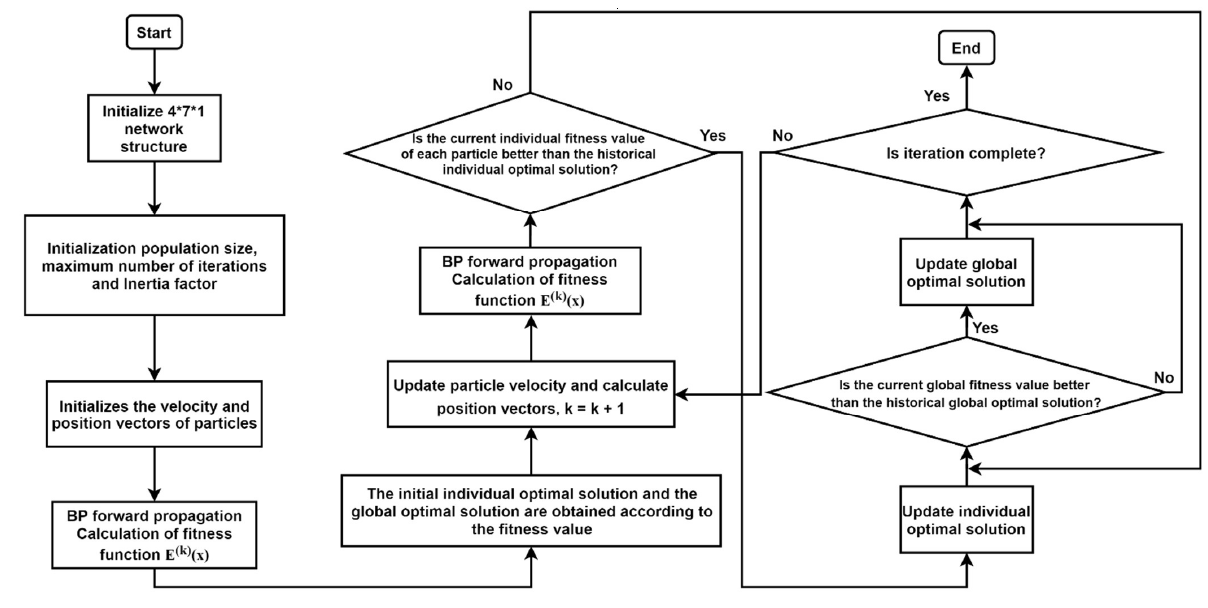
Figure 6. Optimization of BP algorithm flow chart by the particle swarm optimization (PSO) algorithm.